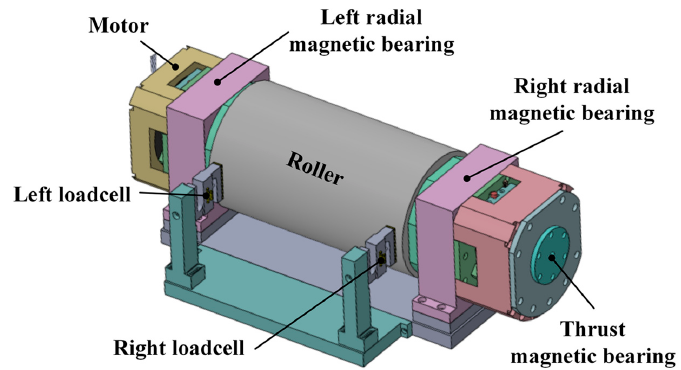
Figure 2. Precision roller testing setup with magnetic bearings for automatic alignment performance assessment.